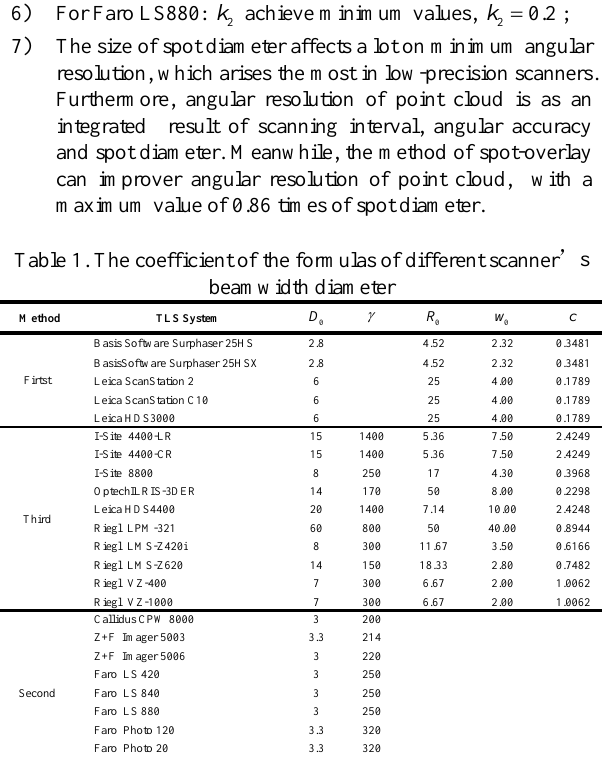
Table 2. The value of the scanning interval the dimensionless theoretical minimum angular resolution Class TLS System Trimble Fine